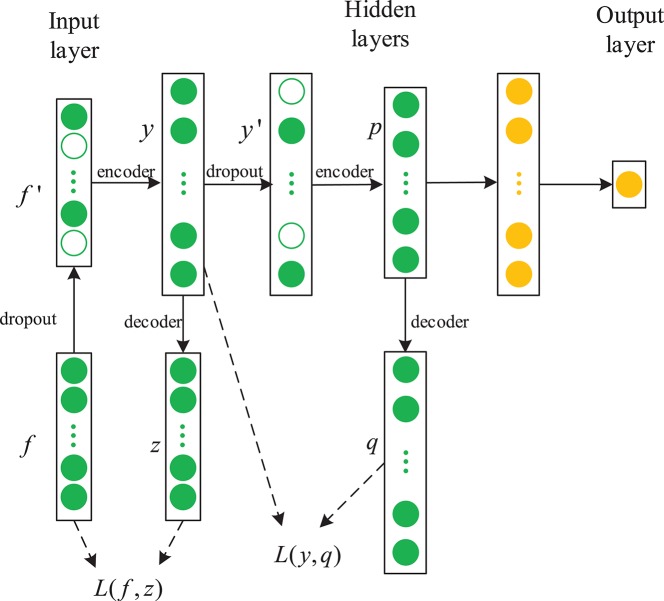
Structure of an SDAE-LSTM network. The green circles represent the layers of SDAEs and the yellow circles are LSTM layers. f′ represents the corrupted input features, y represents the encoded data, and L is a squared loss function.